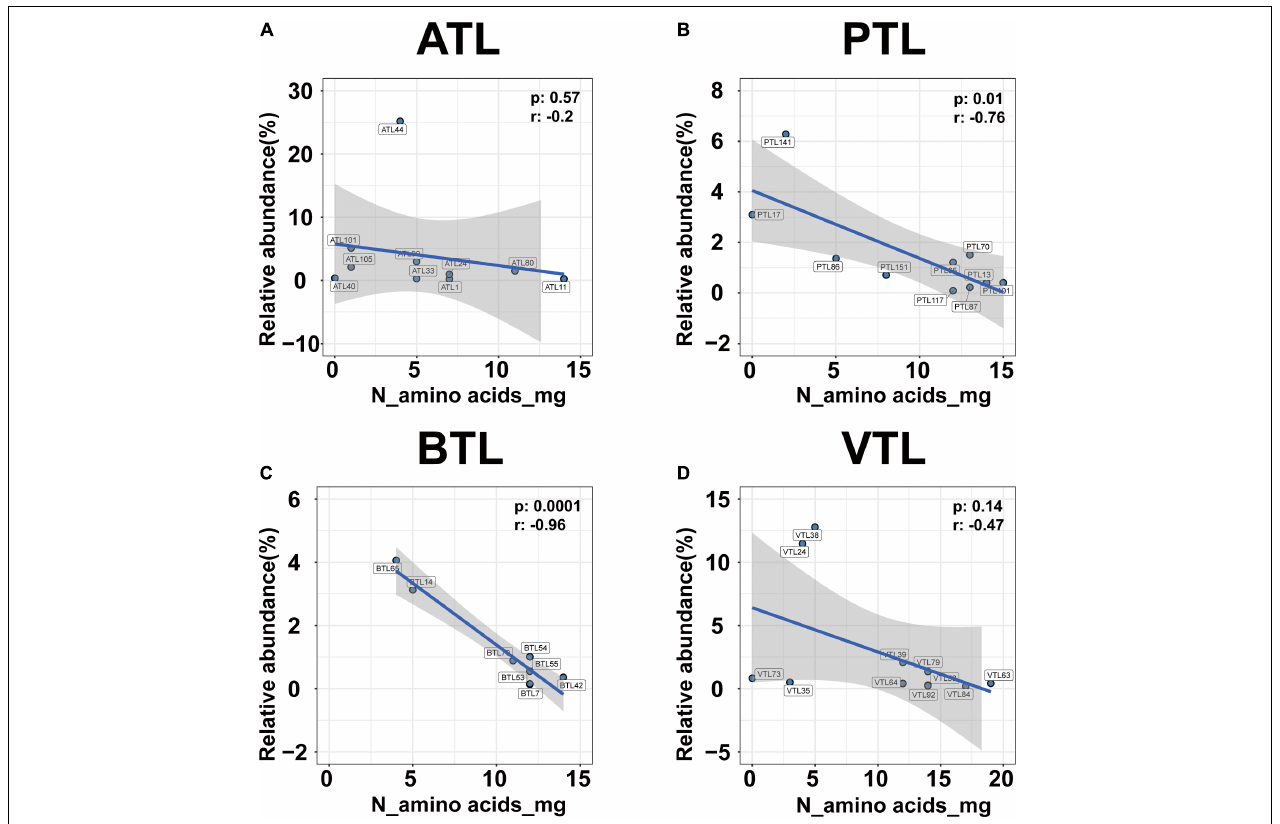
FIGURE 7 | The correlation between the relative abundance and the ability of amino acid synthesis of the MAGs belonging to SAOB at genomic level in ATL (A) , PTL (B) , BTL (C) , and VTL (D) . The ATL, PTL, BTL, and VTL represent the thermophilic methanogenic chemostats supplemented with acetate, propionate, butyrate, and isovalerate as sole carbon source, respectively. The “N_amino acids_mg” represents the number of amino acids that can be synthesized by each MAG at genomic level. The shaded area represents the 95% confidence